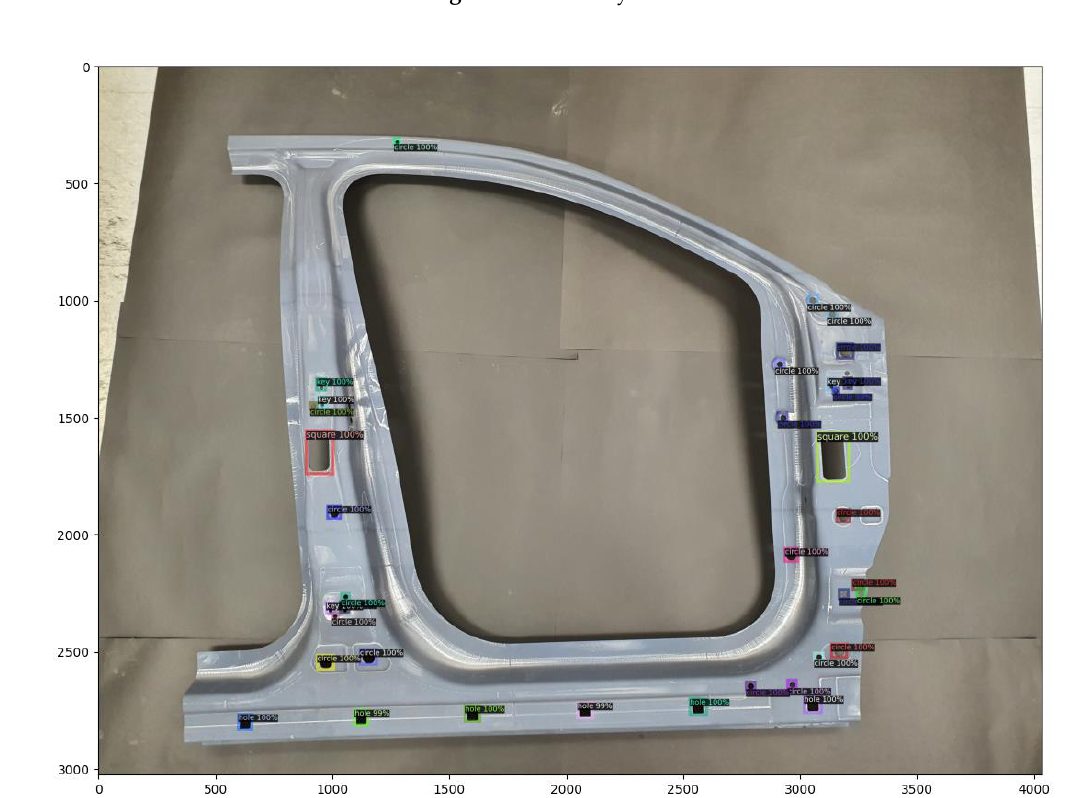
Figure 13. Bounding-box prediction result.